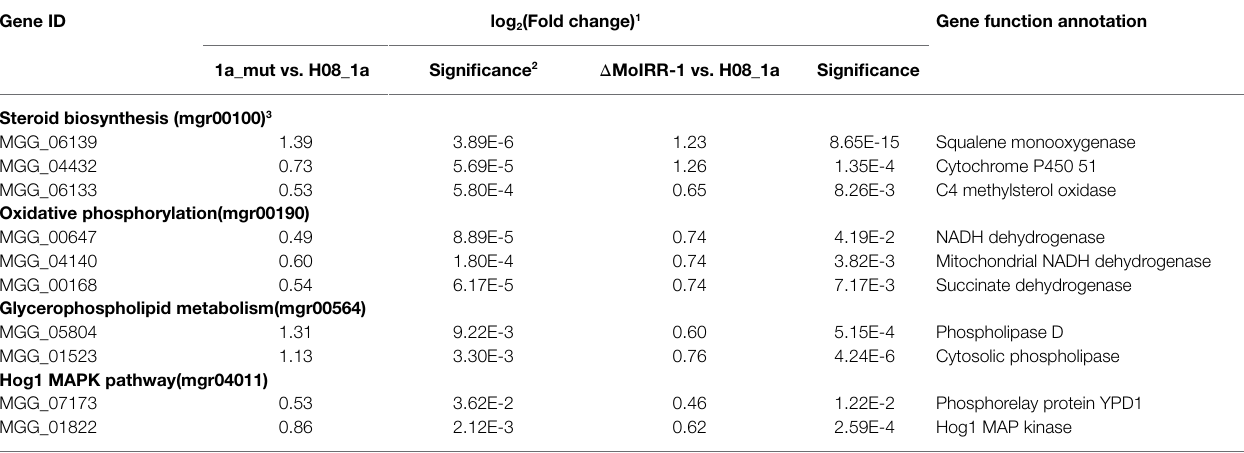
TABLE 2 | Potential fungicide resistance-related genes with similar expression patterns in the transcriptomic analysis of Δ MoIRR-1 and 1a_mut. Gene ID log 2 (Fold change) 1 Gene function